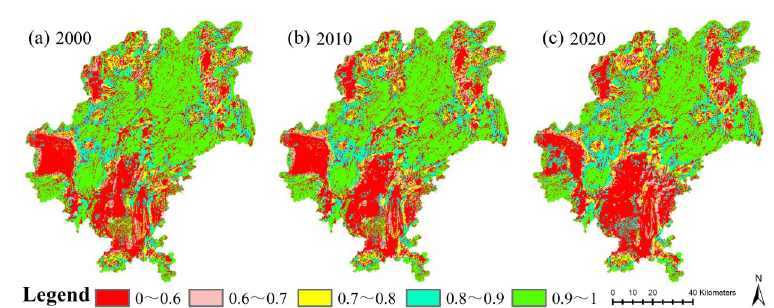
Figure 5. Spatial pattern of the habitat quality in Guiyang